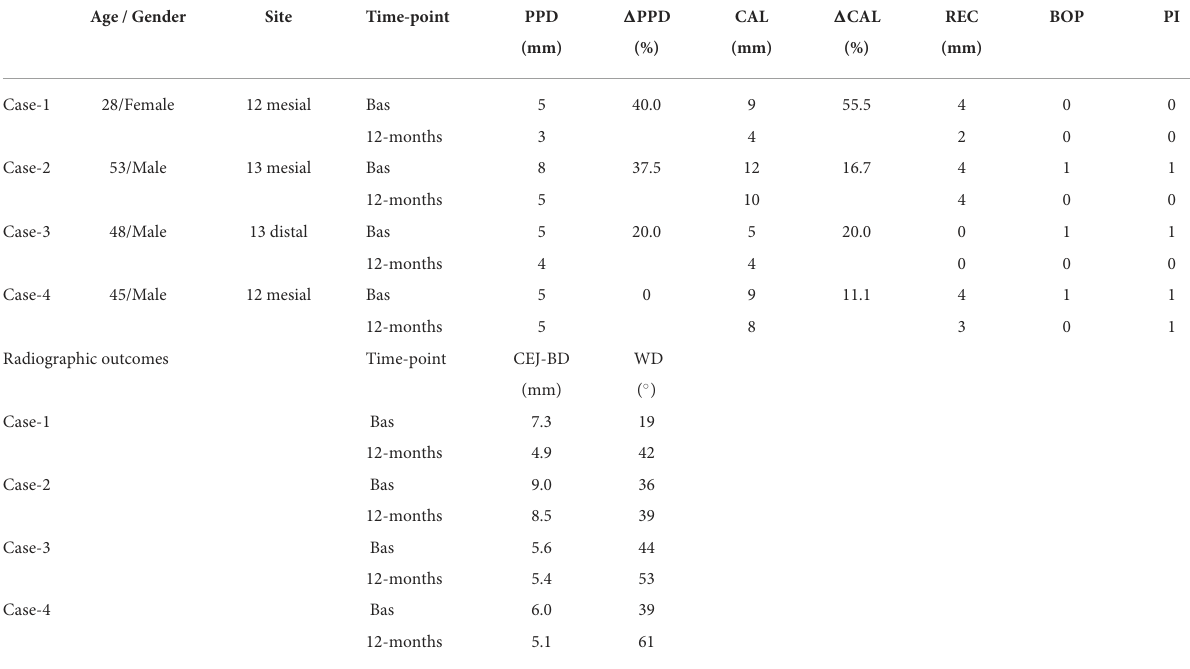
TABLE 1 Baseline characteristics of the participants and clinical/radiographic data between baseline (before anesthesia) and 12-months. Age / Gender